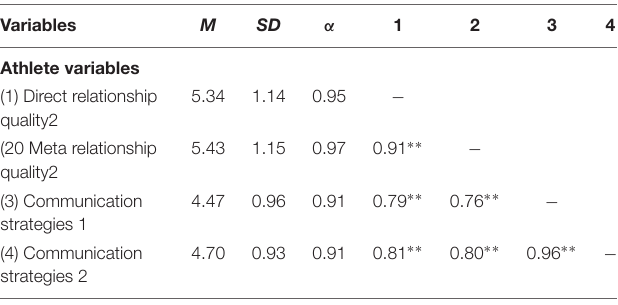
TABLE 2 | Descriptive statistics, Cronbach’s alpha coefficients and inter correlations for all main variables in the study. Variables